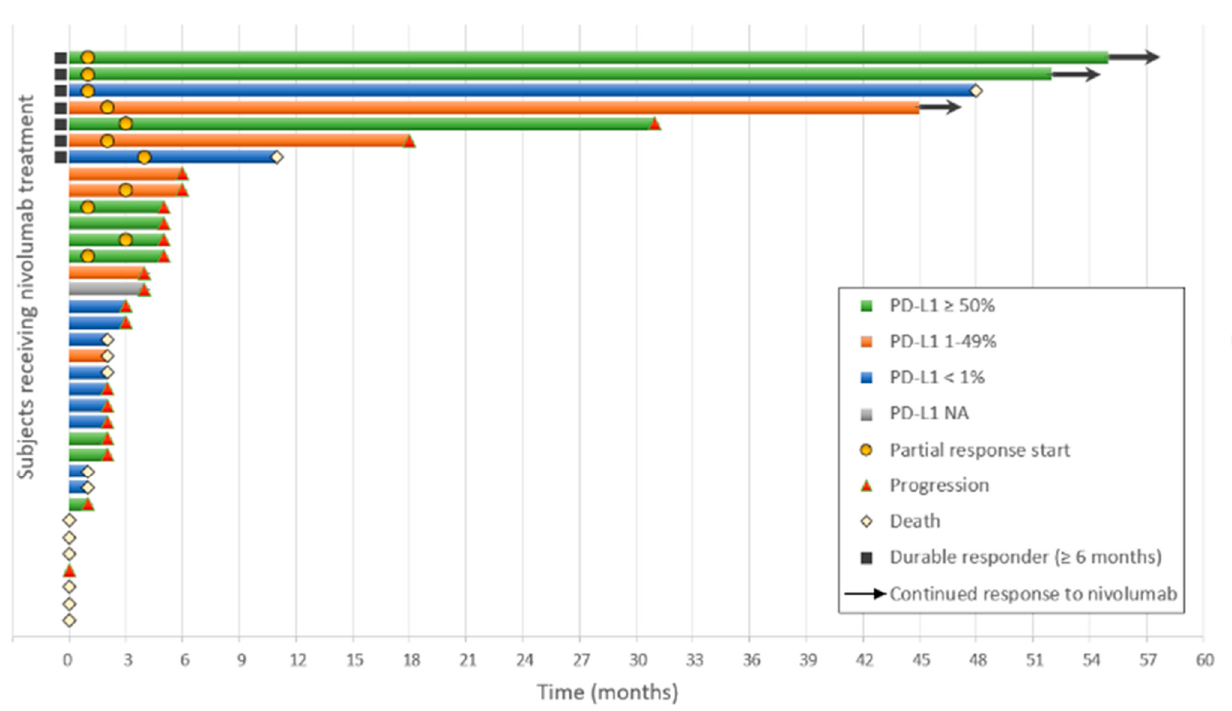
Figure 2. Swimmer plot of tumor response for subjects receiving nivolumab, by month. PD-L1, programmed death-ligand 1.